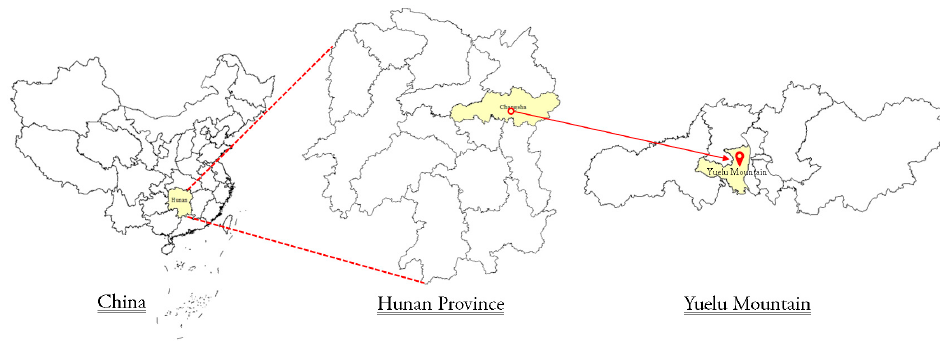
Figure 1. Location of Yuelu Mountain Scenic Area.